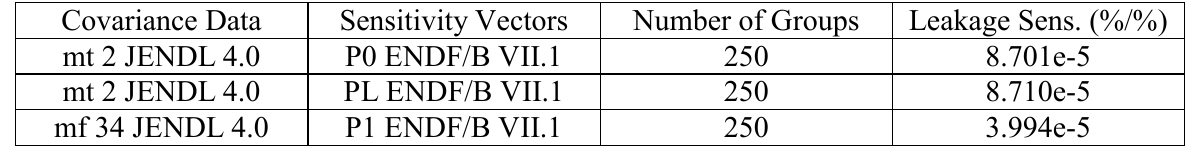
Table II. Relative Leakage Uncertainty from the Concrete Sphere